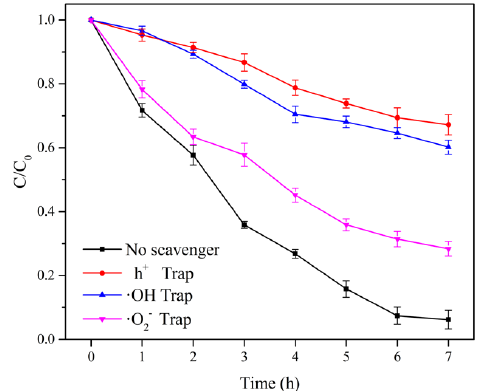
Figure 6. Curves of 1,2,4-TrCB with different trapping agents.